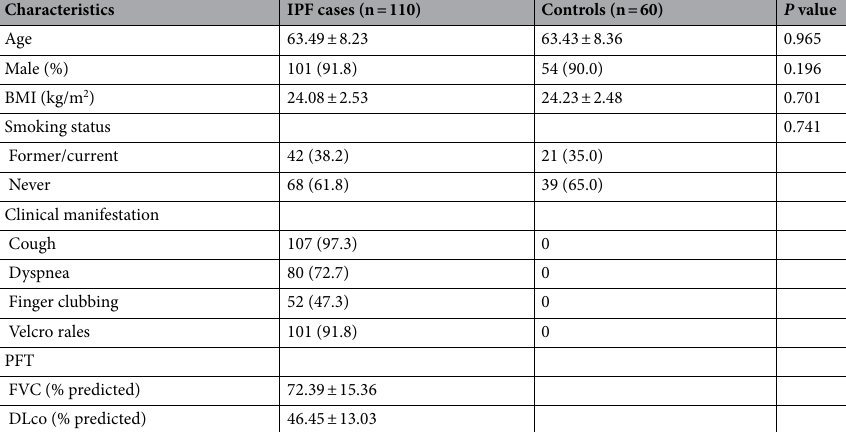
Table 1. Baseline characteristics of the included subjects. All values are reported as mean ± SD = standard deviation or percentage. IPF = idiopathic pulmonary fibrosis; PFT = pulmonary function test; FVC % pred = percent predicted forced vital capacity; DLCO% pred = percent predicted diffusion capacity for carbon monoxide. P values were from the Student’s t test for continuous variables or from the Chi-square test for categorical